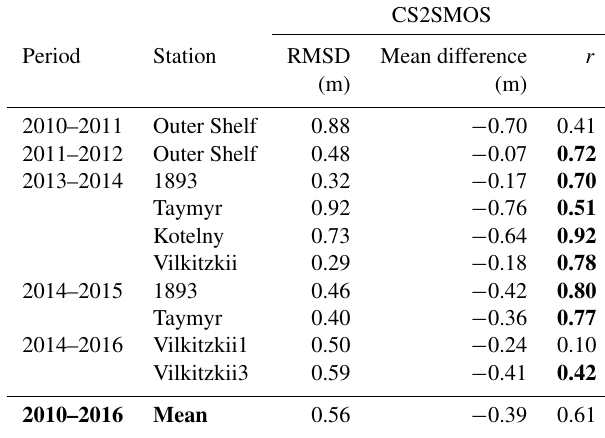
Table 3. Statistics of the comparison of gridded weekly mean CS2SMOS draft data with VAL mean sea ice draft for the period from 2010 to 2016. RMSD and mean difference were calculated for the differences of CS2SMOS minus VAL mean sea ice draft. The Pearson correlation coefficient, r , was calculated for each station. Bold correlation coefficient values indicate significant correlation at the 95% confidence level. The bottom row of values show the aver- ages of RMSD, mean difference and correlation coefficient over all stations. CS2SMOS Period Station RMSD Mean difference r